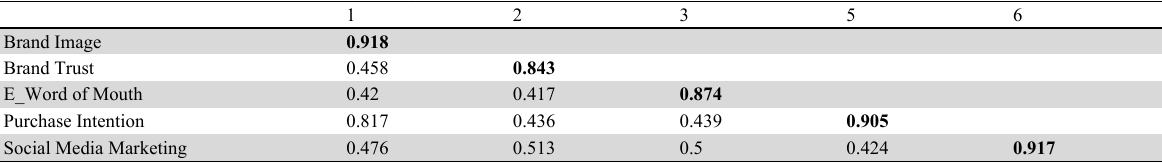
Fornell Larker results of discriminant validity